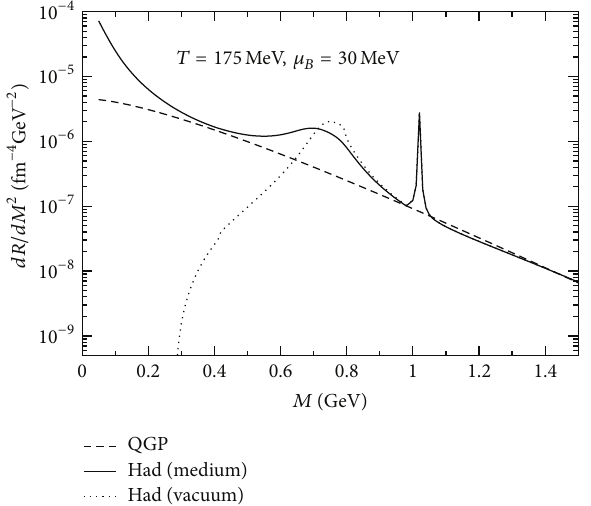
Figure 20: The dilepton emission rate from different sources at 𝑇 = = 30 175 MeV and 𝜇 𝐵